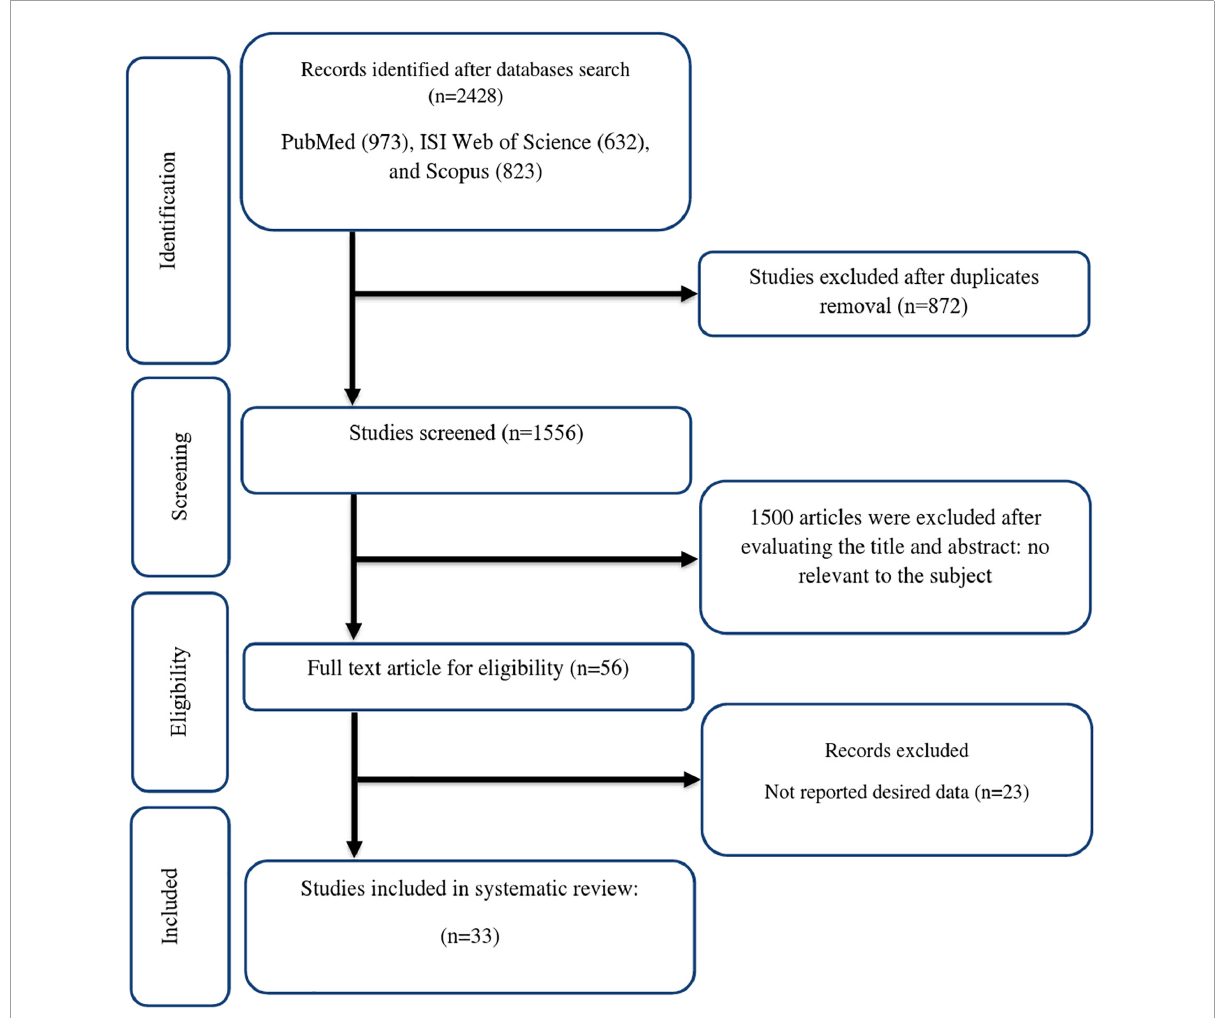
FIGURE1 Flow chart of study selection for inclusion trials in the systematic